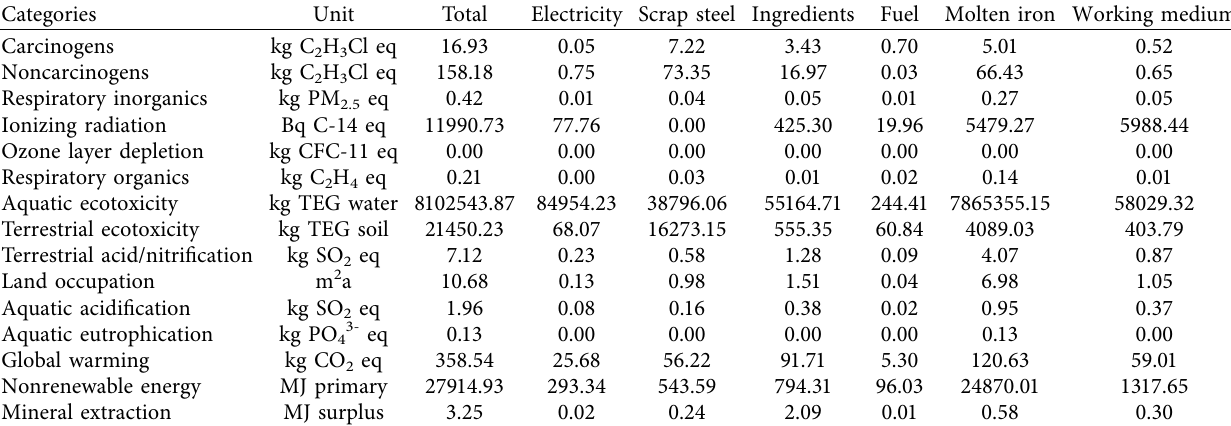
Table 2: Life cycle assessment midpoint results of molten